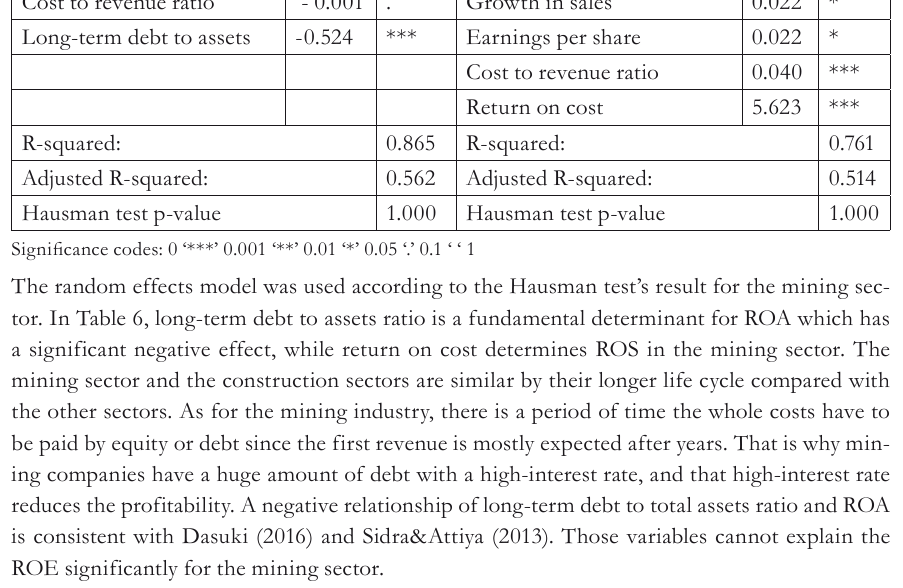
Tab. 7 - Agricultural sector: significant variables predicting ROA and ROS. Source: